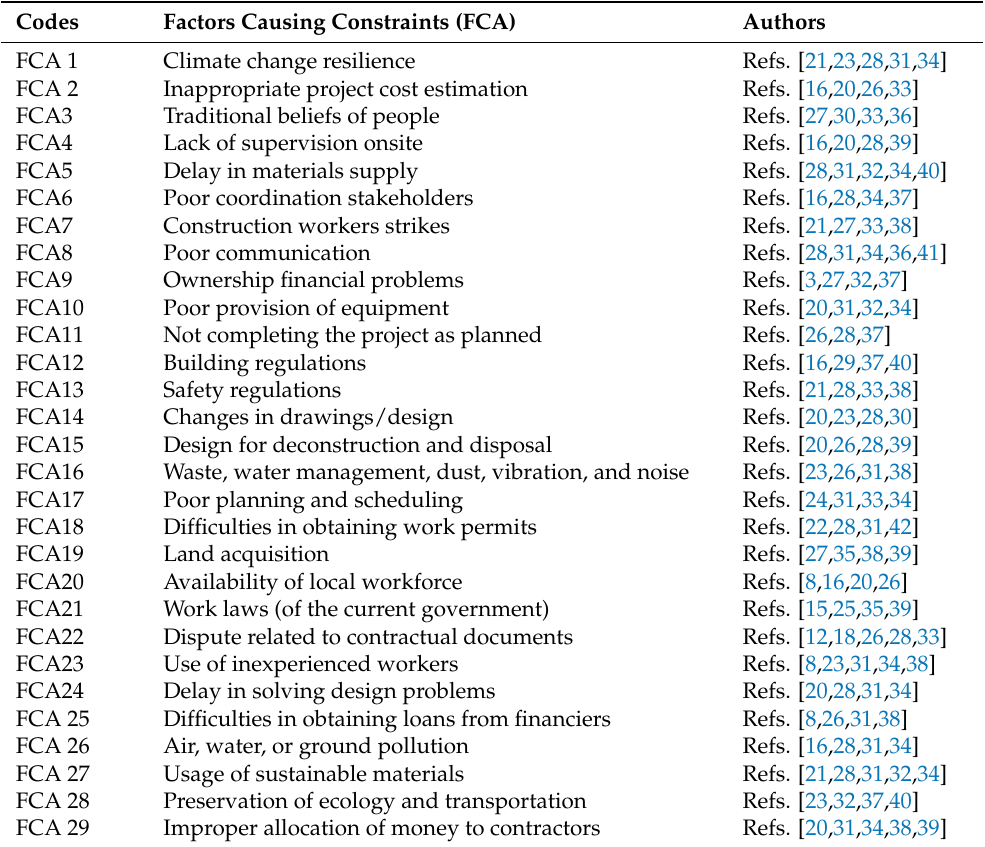
Table 1. Factors causing constraints on construction